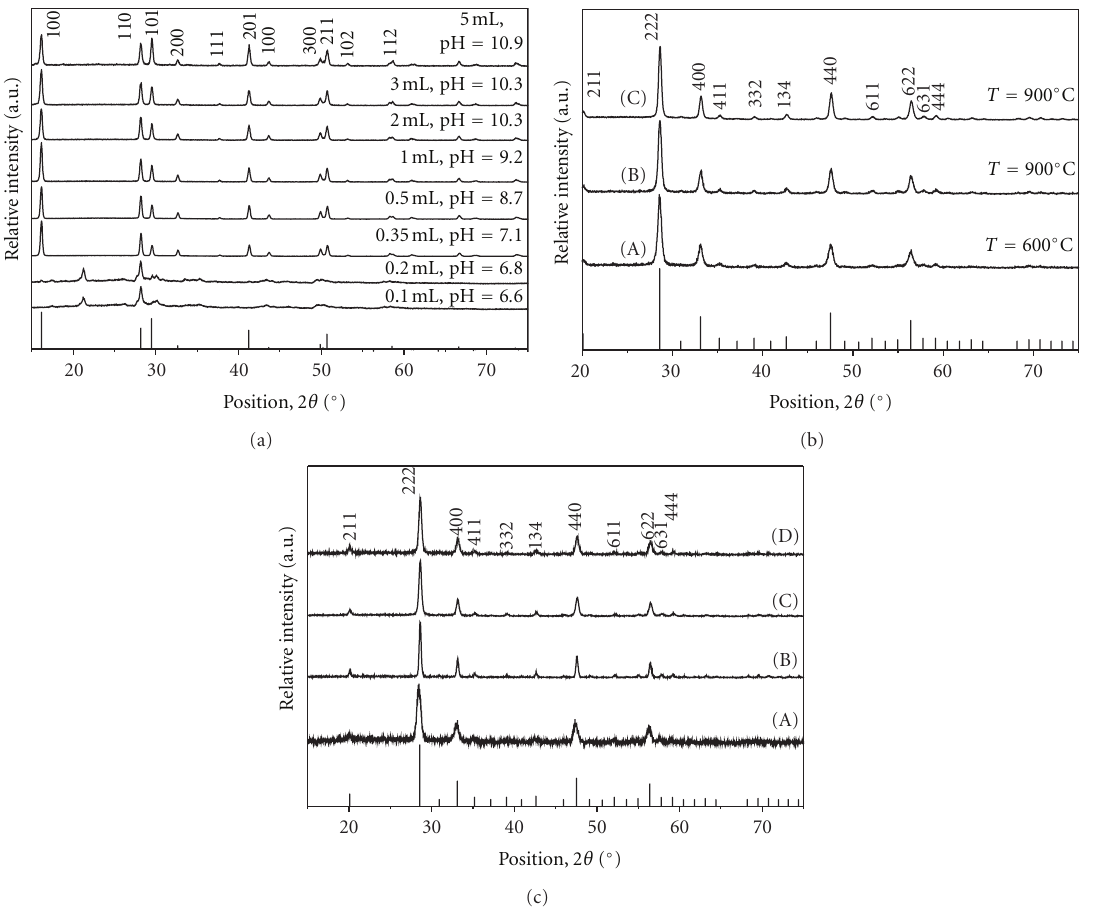
Figure 3: XRD patterns of (a) as-prepared powders obtained by hydrothermal synthesis with various ammonia concentrations, (b) annealed powders (A, B: Rods12 , C: Rods5 ), (c) powders obtained by precipitation methods (A: ParticlesEP , B: ParticlesAP , C: ParticlesHP-CTAB, D: FlakesHP ). Reference: (a) Gd(OH) 3 , [83-2037]; (b), (c) Gd 2 O 3 ,